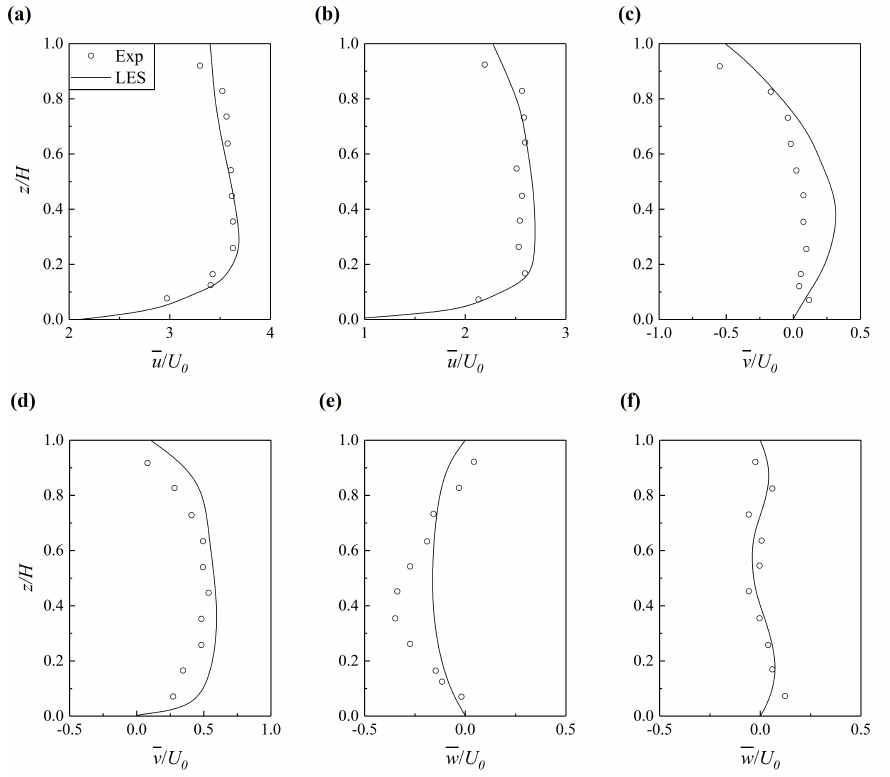
Figure 3. Measured and computed vertical profiles of normalized time-averaged velocity of ( a ) stream- wise component at V1; ( b ) streamwise component at V2; ( c ) spanwise component at V1; ( d ) spanwise component at V2; ( e ) vertical component at V1; ( f ) spanwise component at